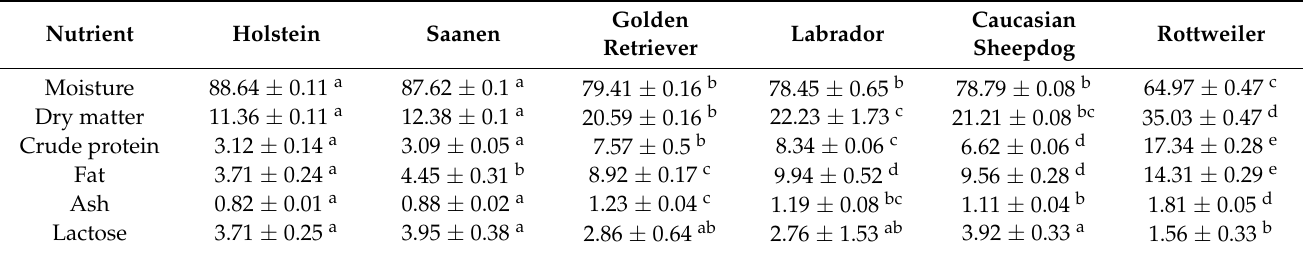
β -lactoglobulin ( β -LG), lysozyme, and serum albumin. The molecular weight of casein Values within each row with different superscripts were significantly different ( p < 0.05). Data are 200 ranged from 19 to 35 kDa. presented as the mean ± standard deviation, n = 3. Table 1. The chemical composition of canine, bovine, and caprine milk (g/100 mL). Golden Saanen Retriever